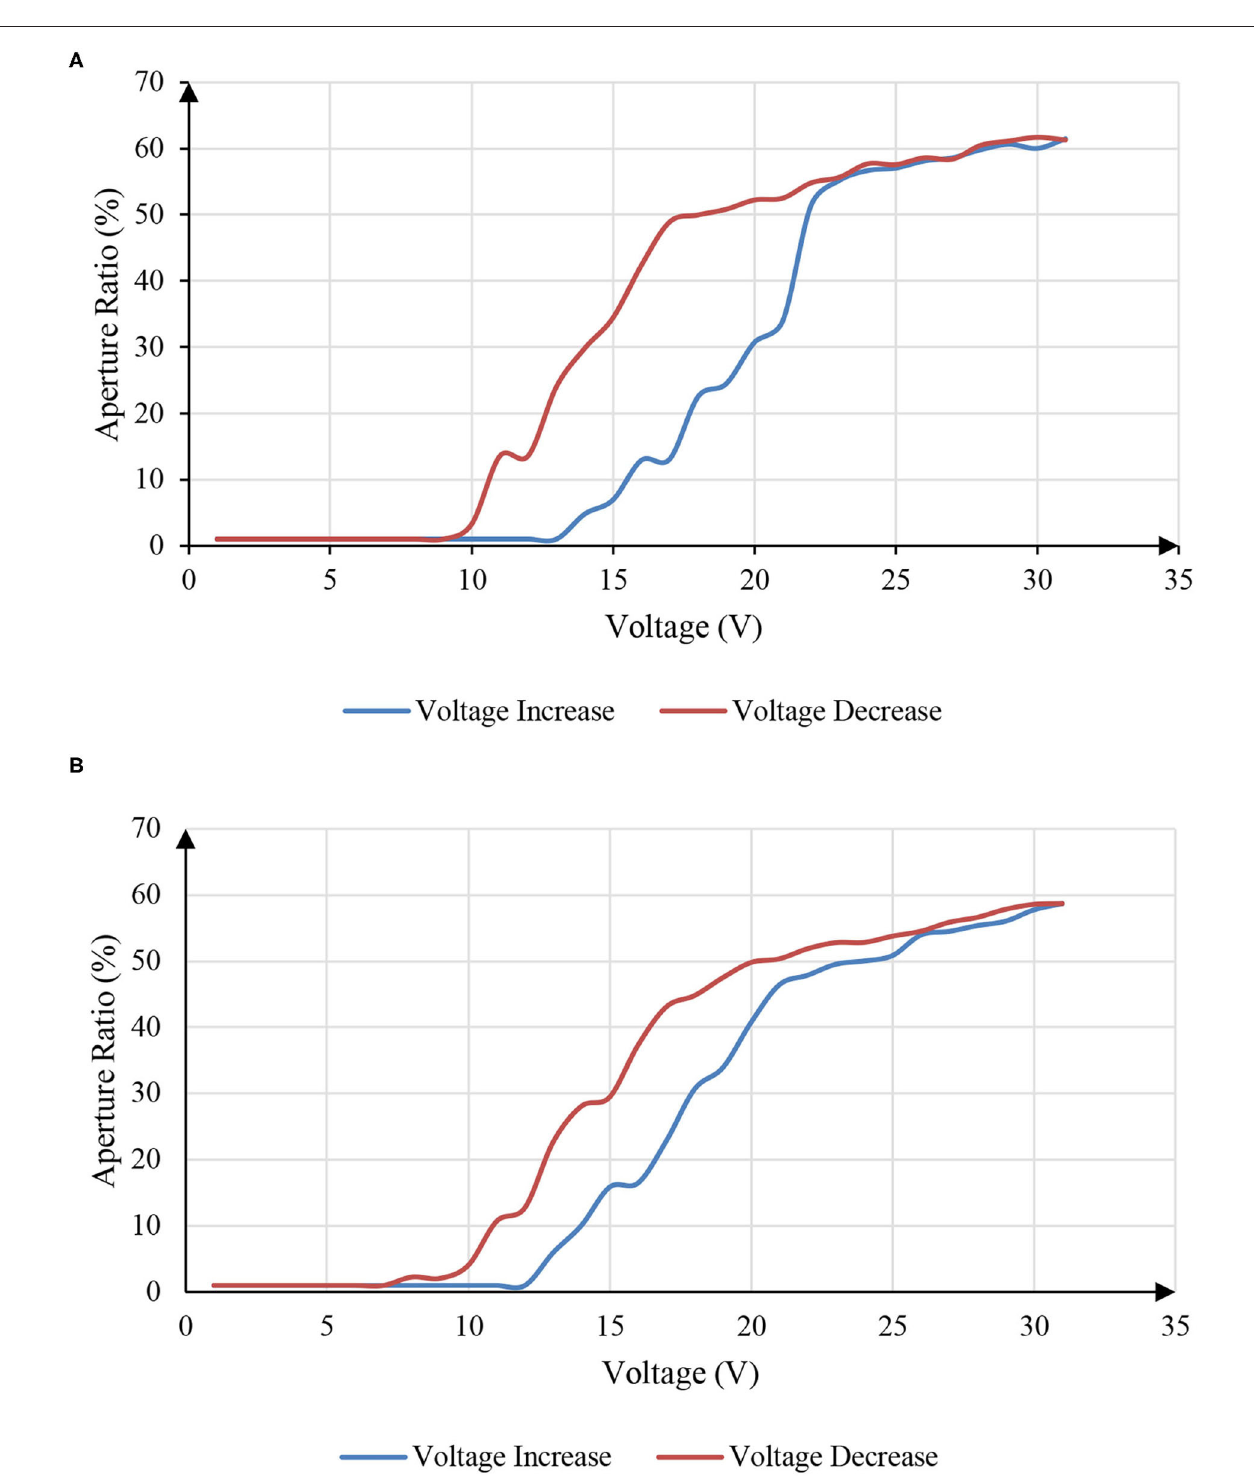
FIGURE 6 | Hysteresis curves of an EWD driven by DC driving scheme and AC driving scheme. The black curve showed the aperture ratio when driving voltage was increased from 0 to 30V, and the red curve showed the aperture ratio when driving voltage was decreased from 30 to 0V. (A) The hysteresis curve of an EWD driven by DC driving scheme. (B) The hysteresis curve of an EWD driven by AC driving scheme.